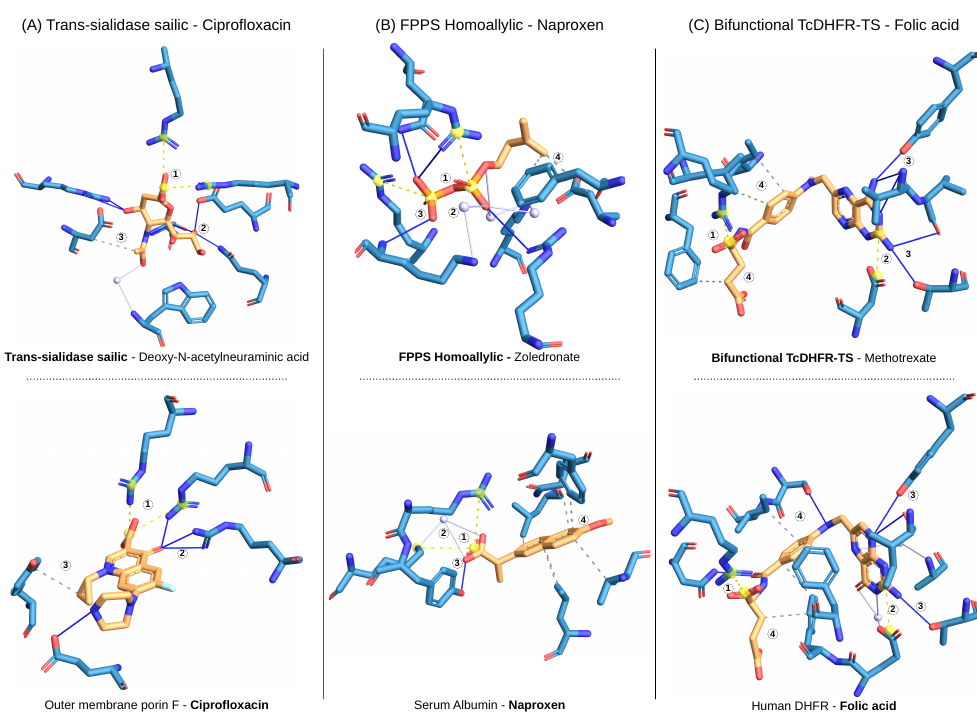
Figure 3. Non-covalent interaction patterns accounting for the repositioning predictions. The structure-based drug repositioning approach predicted that ciprofloxacin binds trans-sialidase (sialic acid site), naproxen binds FPPS (homoallylic site) binder, and folic acid binds TcDHFR. The repositioning is based on the similarity of the non-covalent interactions defining the binding mode of inhibitors (orange) to their targets (blue) between query (top) and hit (bottom) complexes. ( A ) The binding mode of ciprofloxacin to porin F (PDB ID: 4kra) is similar to the one of deoxy-N-acetylneuraminic acid to trans-sialidase (sialic acid site) (PDB ID: 1ms0). Both have in common (1) a double salt bridge (yellow dashed lines), (2) a triple set of hydrogen bonds (blue lines), and (3) a hydrophobic interaction (gray dashed lines). In the same way, ( B ) the binding mode of naproxen to serum albumin (PDB ID: 4ot2) is similar to the one of zoledronate to FPPS (PDB ID: 3iba) as they have (1) two salt bridges, (2) one water bridge (lightblue lines and sphere), and (3) one hydrogen bond in common. ( C ) The binding mode of folic acid to human DHFR (PDB ID: 1drf) is similar to the one of methotrexate to TcDHFR (PDB ID: 3cl9) with (1,2) two salt bridges, (3) a set of hydrogen bonds, and (4) a set of hydrophobic